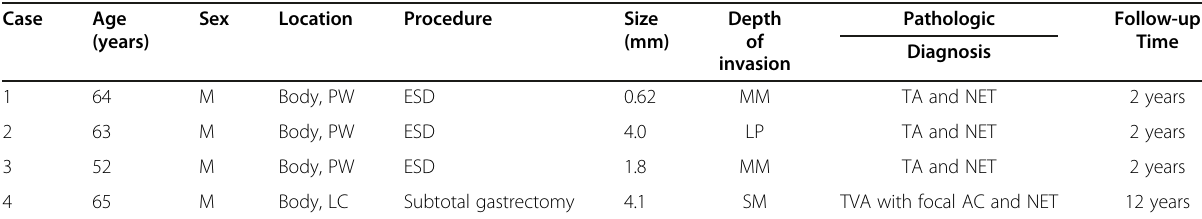
Table 1 Clinical and Pathologic Characteristics of cases with gastric adenoma-neuroendocrine tumor